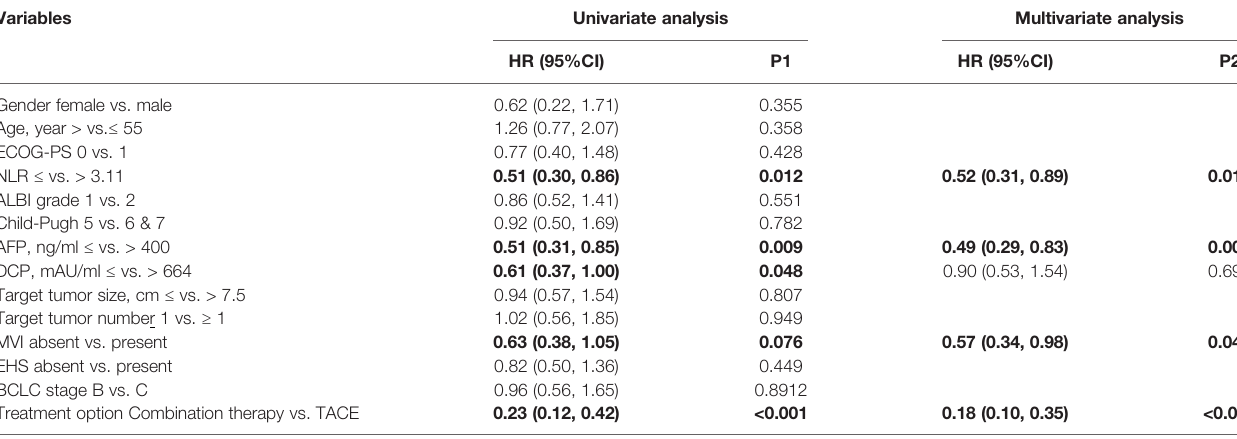
The bold values highlighted the factors with signi fi cant difference. P1 value was calculated with log-rank test. Any variables that were statistically signi fi cant at P < 0.1 in the univariate analysis were used in multivariate analyses using Cox regression analysis. P2 value was calculated by multivariable Cox proportional-hazards